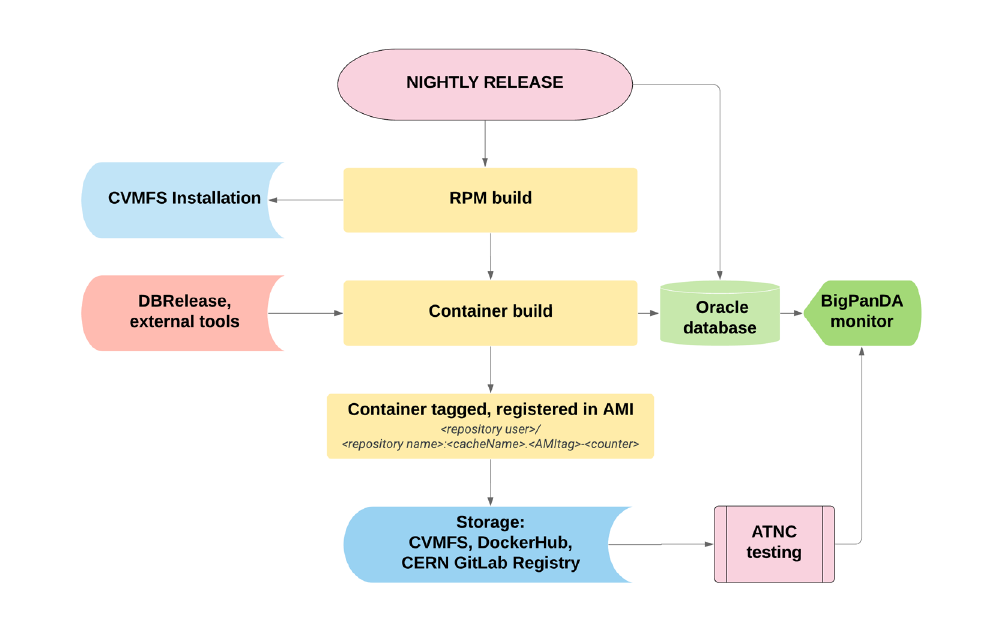
Figure 4. Diagram showing the stages of nightly container